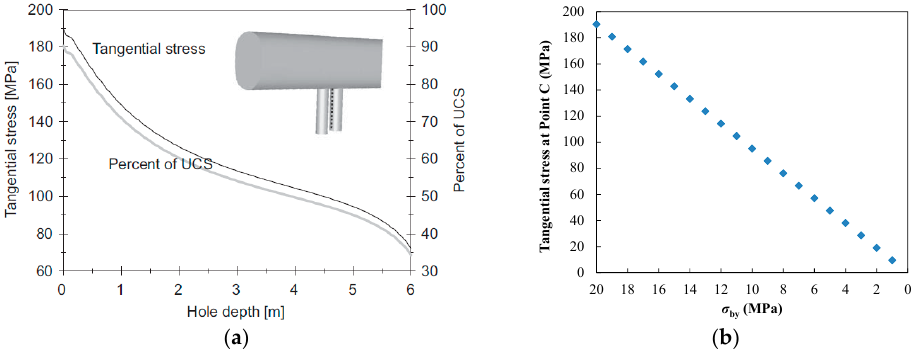
Figure 6. Excavation-induced tangential stress at Point C of the pillar: ( a ) Monitoring result [35], courtesy of SKB (from SKB TR-07-01 (Andersson 2007)); ( b ) simulated result with different boundary stress σ by